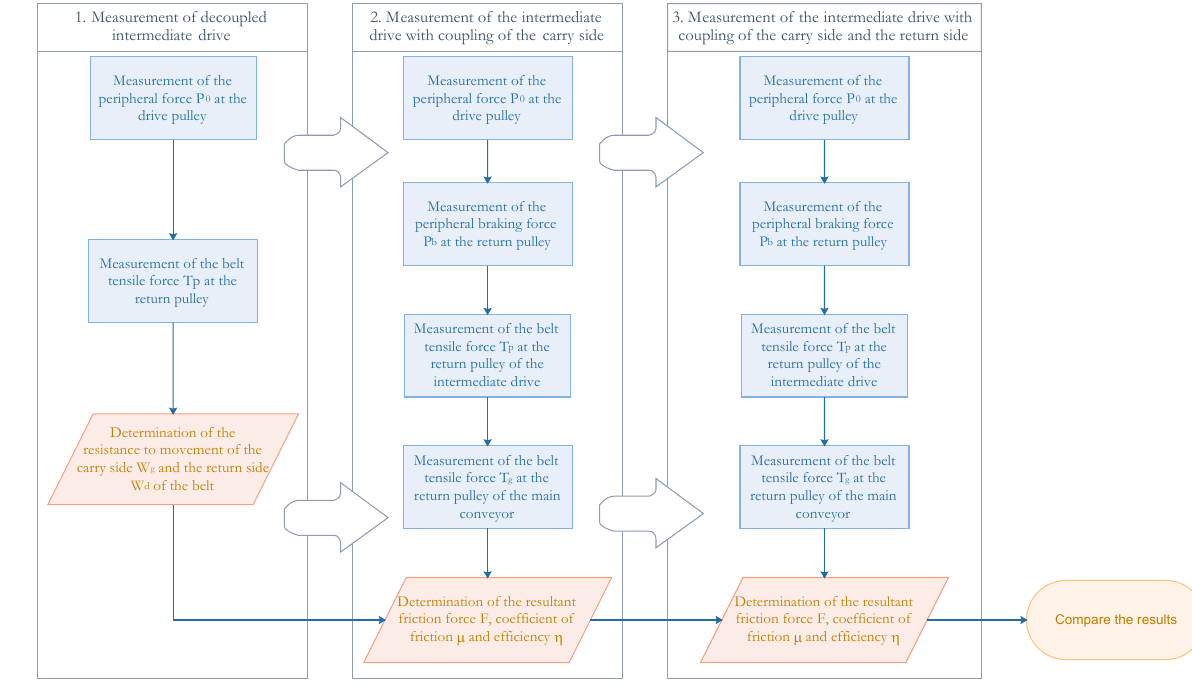
Figure 5. Measurement